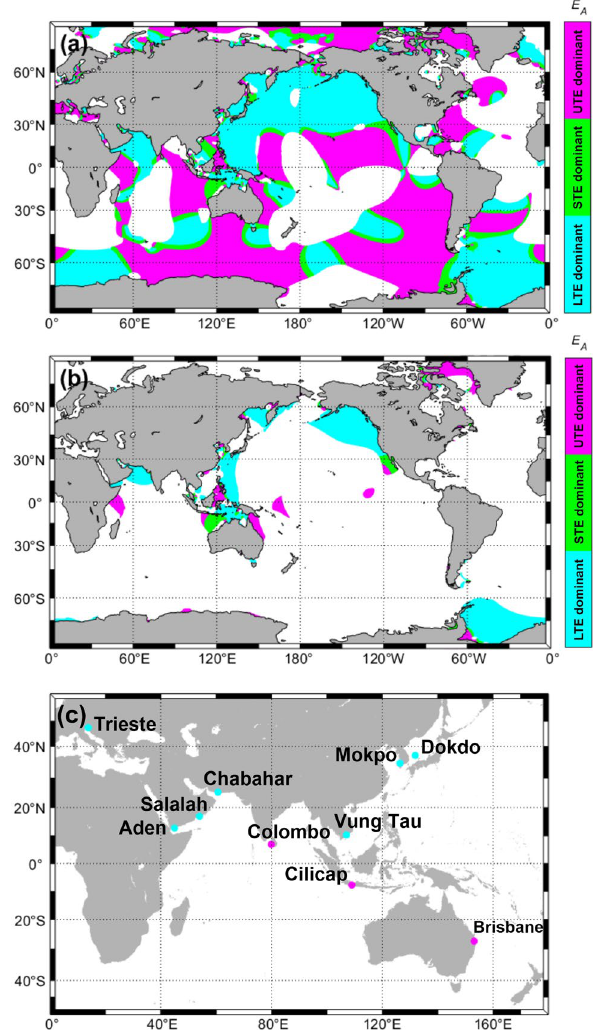
Figure 4. ( a ) Distribution of monthly tidal envelope types throughout the mixed tide regime areas of the globe (0.25 < F < 3.0) classified using E A ; ( b ) global distribution of mixed tidal regimes with tidal ranges > 2 m, also classified using E A ; and ( c ) locations of the ten sea level observation sites analyzed in Table 2 (pink and blue dots indicate UTE and LTE dominant locations, respectively). Maps were derived from the FES2014 tidal harmonic constants